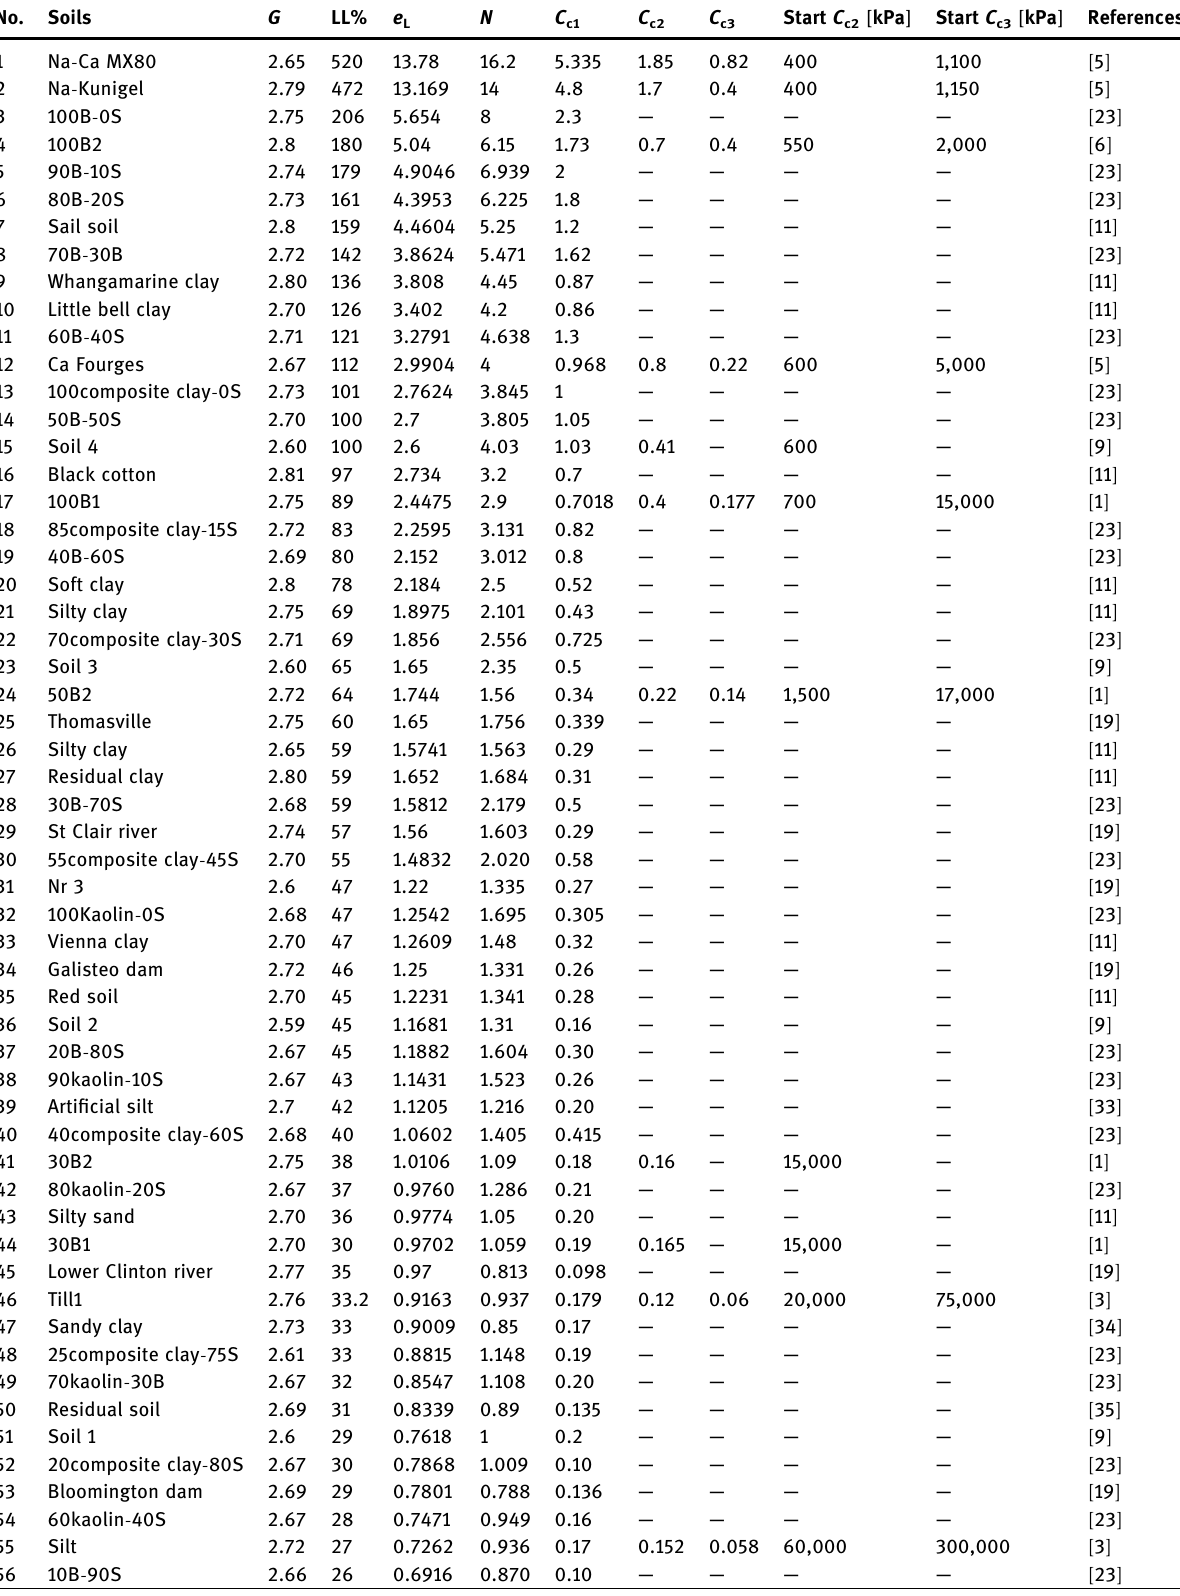
Table 2: The NCL properties of 59 di ff erent soils used in this study No.